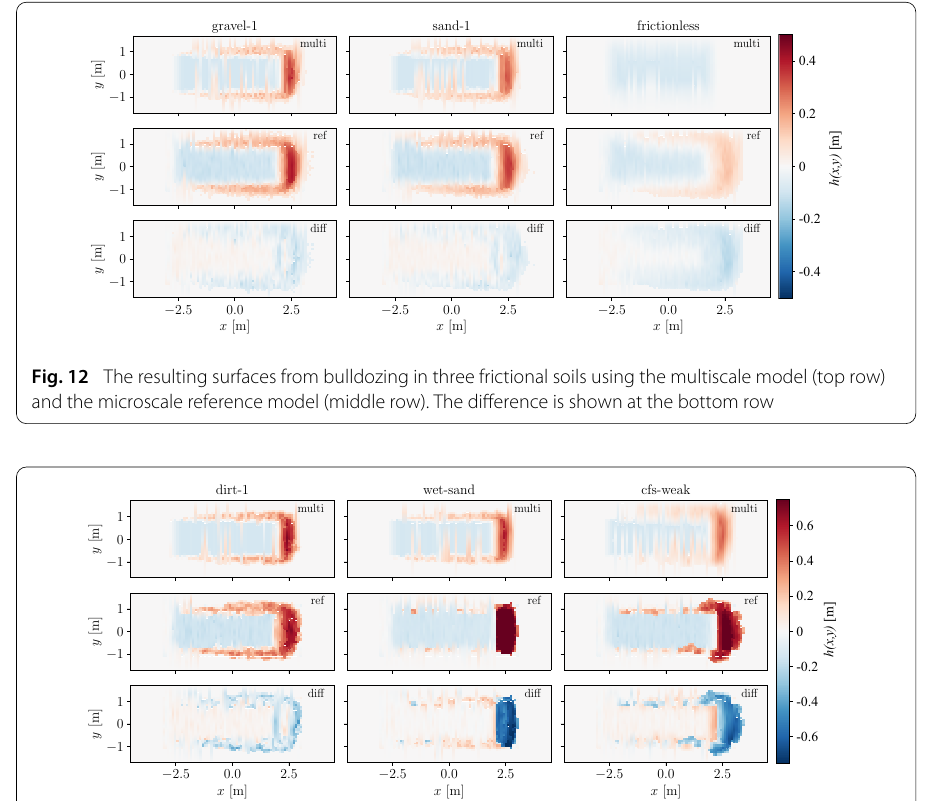
deviation between the models is larger. The reference model with dirt-1 give wider side berms and a wider pile. The relative error is up to 50%. For the strongly cohesive soils ( wet-sand-1 and cfs-medium ) the difference is even larger, up to 100%. For the reference model almost all soil is accumulated in front of the blade. The particle cohesion appear to be much stronger in the reference model than with the multiscale